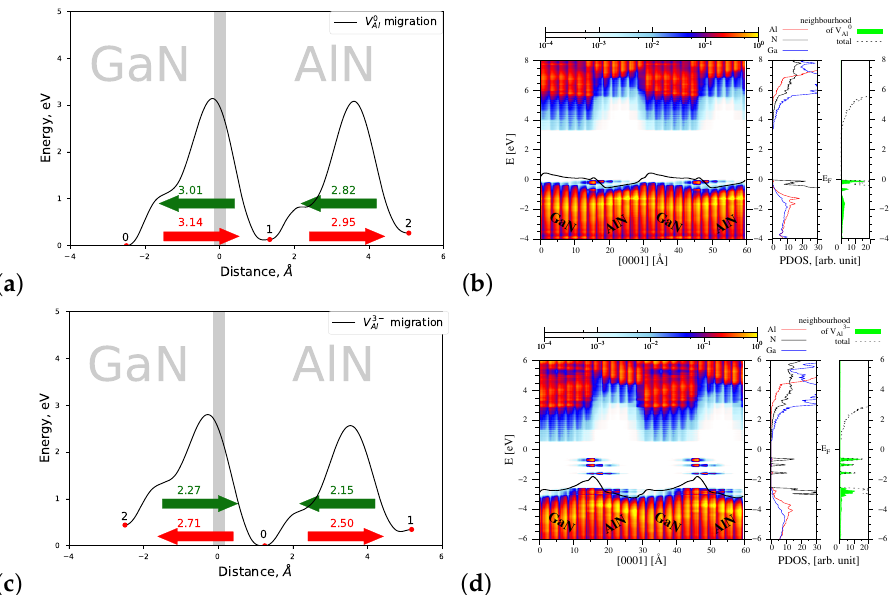
Figure 11. Left—joint profiles of the migration energy barrier of aluminium vacancy V Al at the AlN/GaN interface, right—the density of states projected on the atom quantum states (P-DOS), showing the spatial variation of the valence and conduction bands in the GaN/AlN and the total DOS is denoted by black dashed line; DOS associated with Al, N, and Ga atoms are denoted by red, black, and blue line, respectively; The green shade represents sum of the PDOS from the nearest neighbors of V Al . ( a , b ) V 0 , the corresponding potential jump ∆ V = 0.61 eV ( c , d ) V 3 − Al potential jump ∆ V = 0.56 eV.